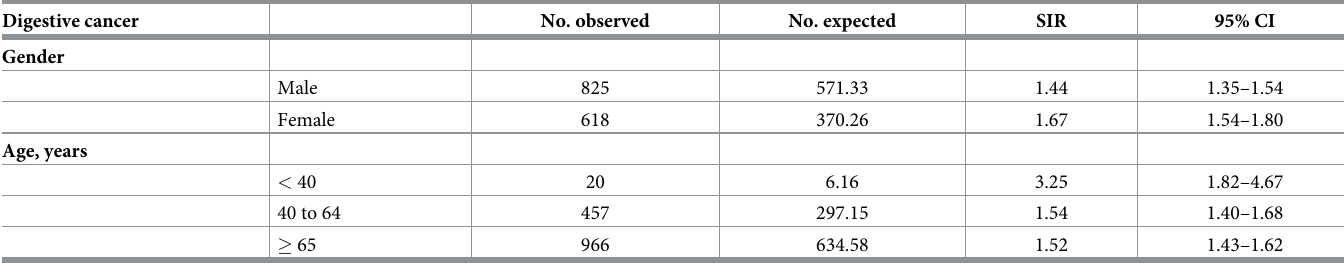
Table 3. Standardized incidence ratio of overall digestive cancer in CKD diagnosed patients compared with cohort population stratified by gender and age. Digestive